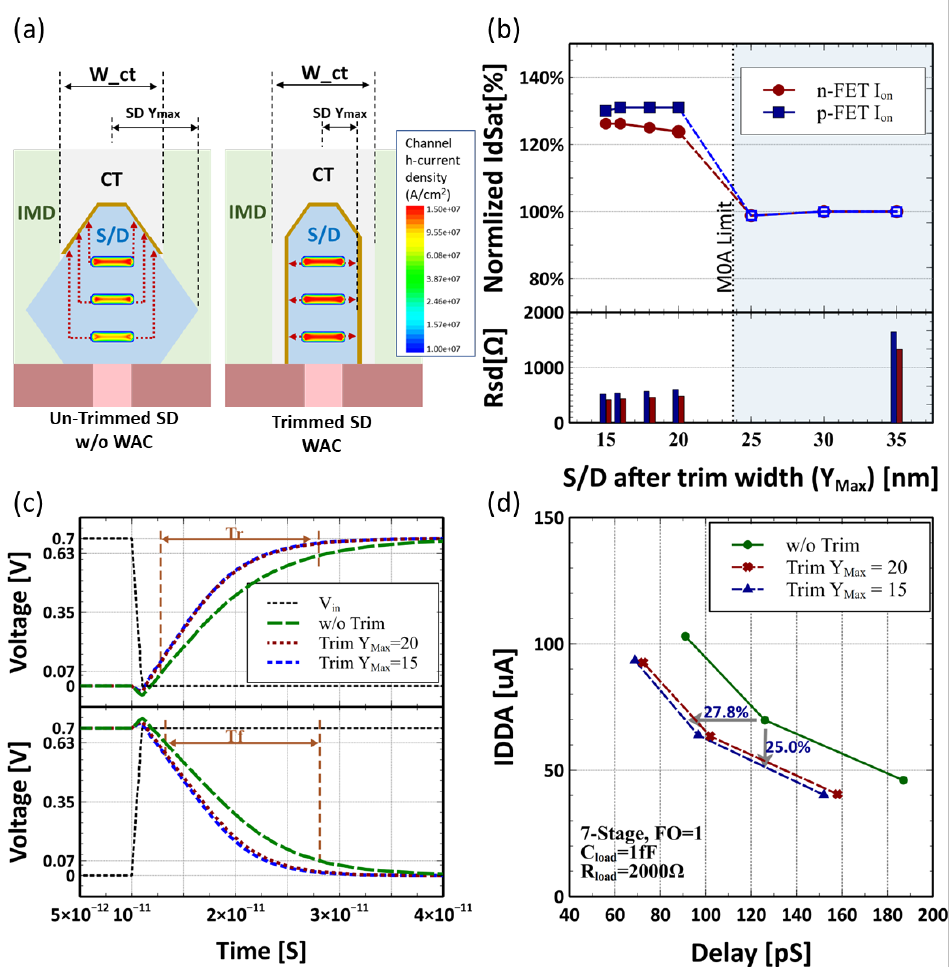
Figure 3. ( a ) Current from bottom NS of trimmed S/D and WAC has much a shorter distance to contact compared to an un-trimmed case, resulting in a more equally distributed current between all three nanosheets and better efficiency; ( b ) ion performance and extracted Rsd at varied S/D trimming position; ( c ) switch delay of an inverter on a fixed load of 1fF. Both Tr and Tf of NS-FETs reduce with S/D trimming; ( d ) power–delay curve of a constructed 7-stage ring